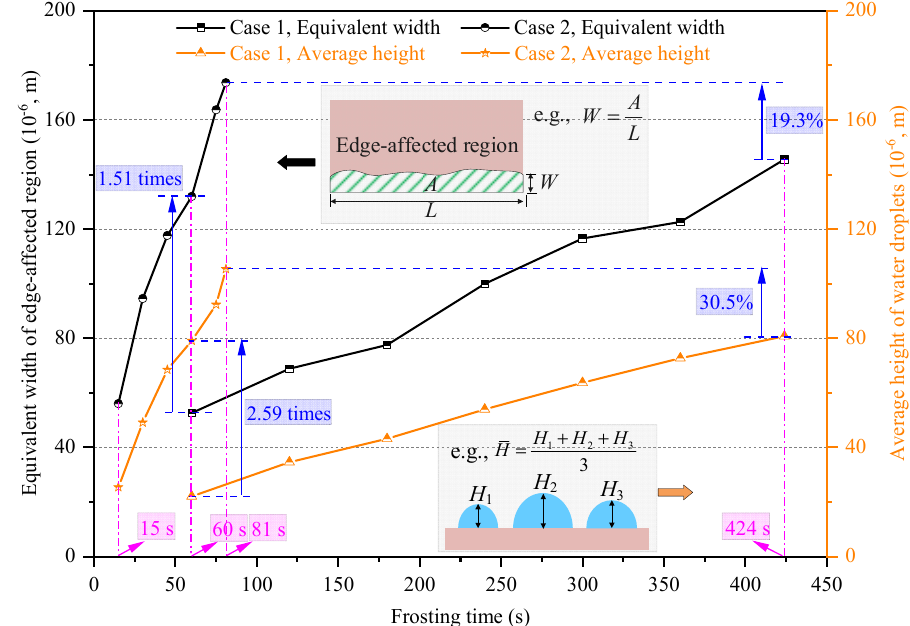
Figure 7. The equivalent width of the edge-affected region and average height of water droplets in the edge-affected region.